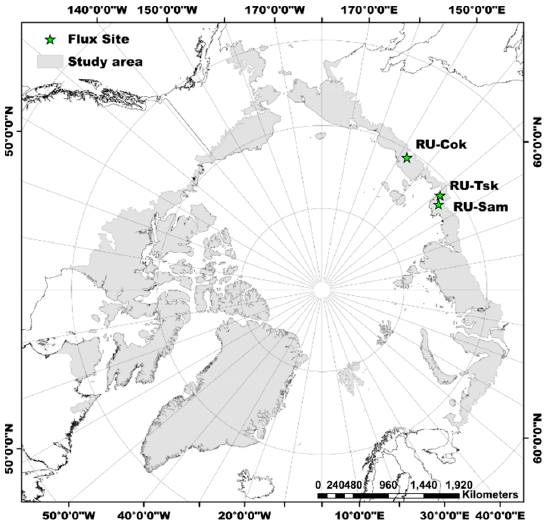
Figure 1. Spatial extent of the tundra region of the study. The green pentagrams denote the eddy-covariance (EC) flux sites within the study area.